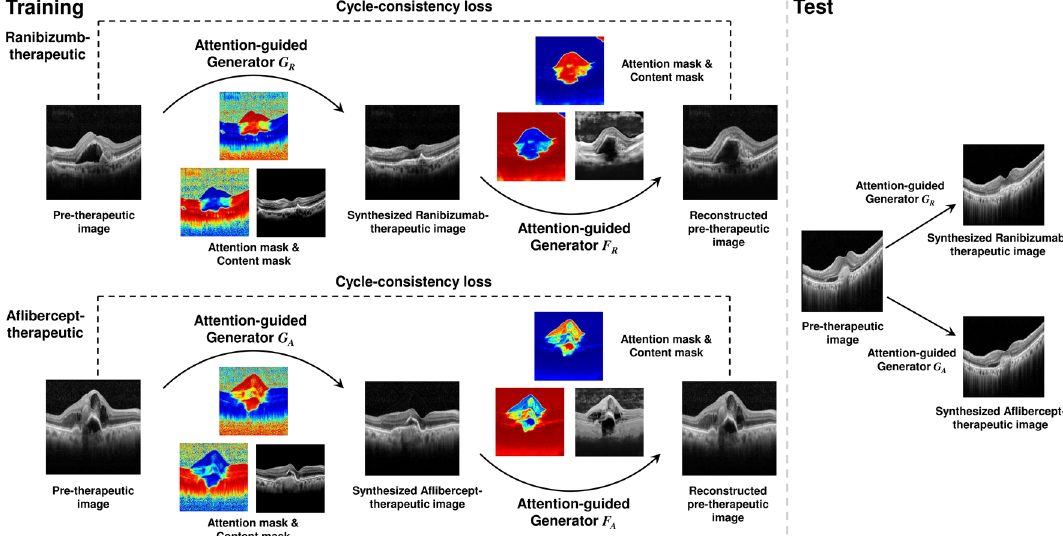
Figure 1. Overview of the proposed post-therapeutic optical coherence tomography image synthesis model. Models are trained with a training set of each anti-vascular endothelial growth factor agent. For ranibizumab, the model consists of two attention-guided generators, G-ranibizumab and F-ranibizumab. For aflibercept, the model consists of G-aflibercept and F-aflibercept. Each generator aims to detect the discriminative pixel of the image. After that, the input image, content mask, and attention mask are mixed to manufacture the synthesized therapeutic image or reconstructed pre-therapeutic image. Moreover, the models are constrained by cycle- consistency